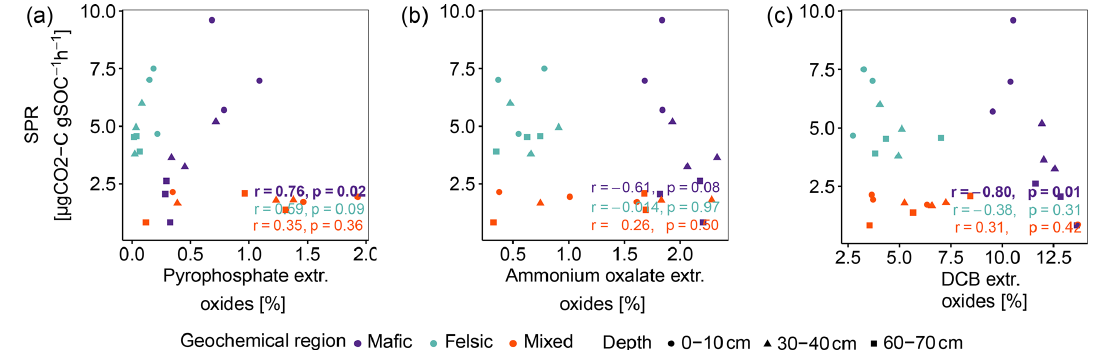
Figure A3. Pearson correlation between SPR and sum of pedogenic oxides (Al, Fe and Mn). (a) Sodium pyrophosphate extractable oxides, (b) ammonium oxalate-oxalic acid extractable oxides and (c) dithionite-citrate bicarbonate extractable oxides. p values in bold indicate significant results at p < 0.05. Data reported by Reichenbach et al. (2021).